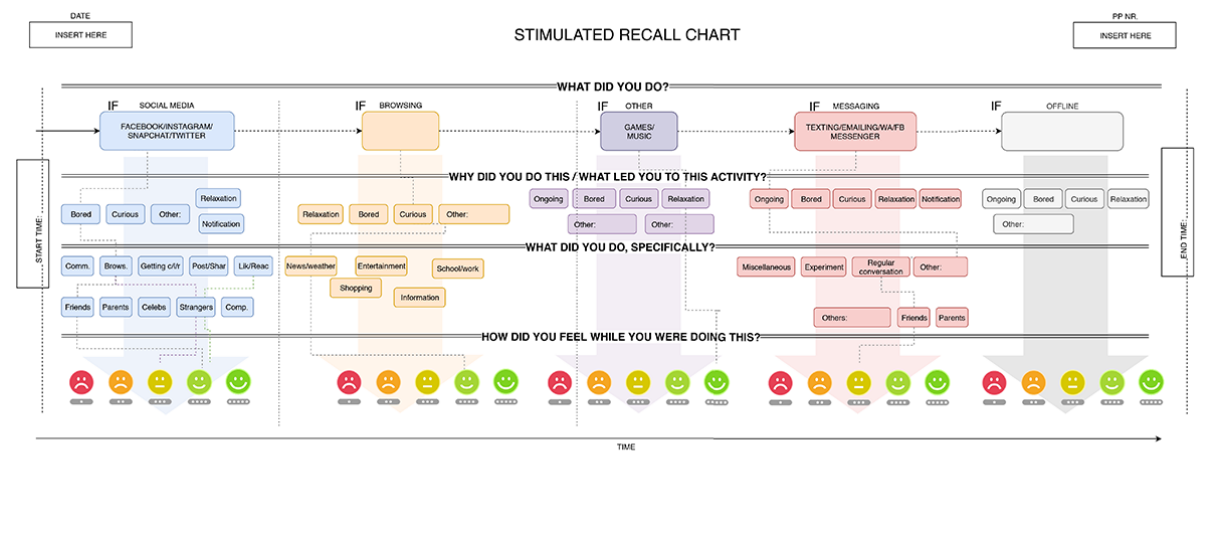
Figure 4. Schematic interview chart used to aid in the stimulated recall